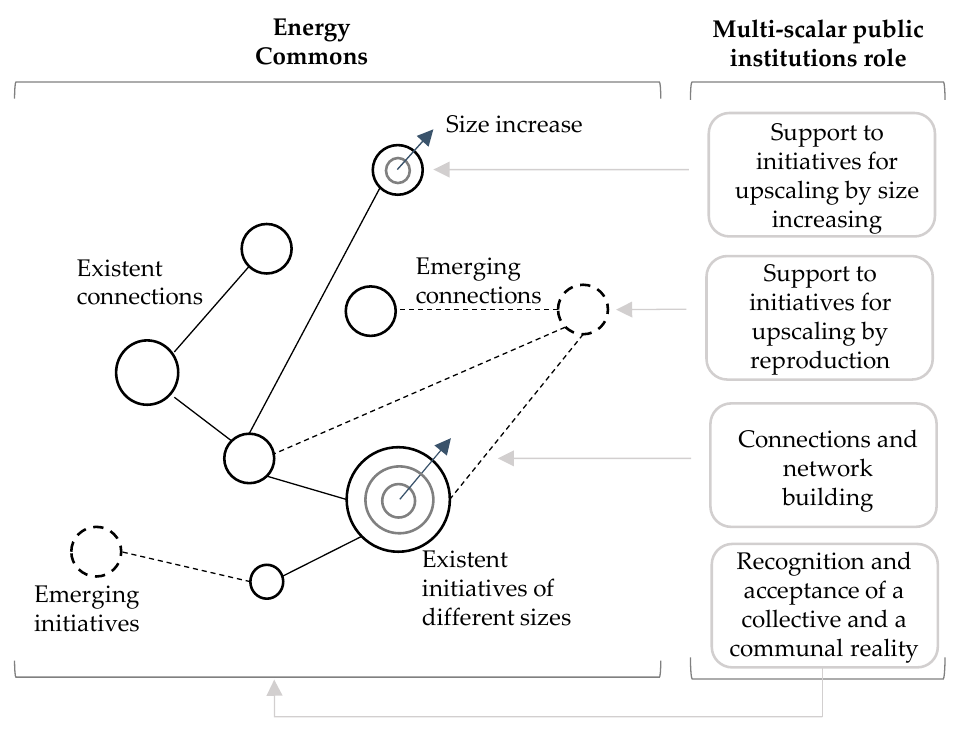
Figure 3. Public institutions role fostering Energy Commons.